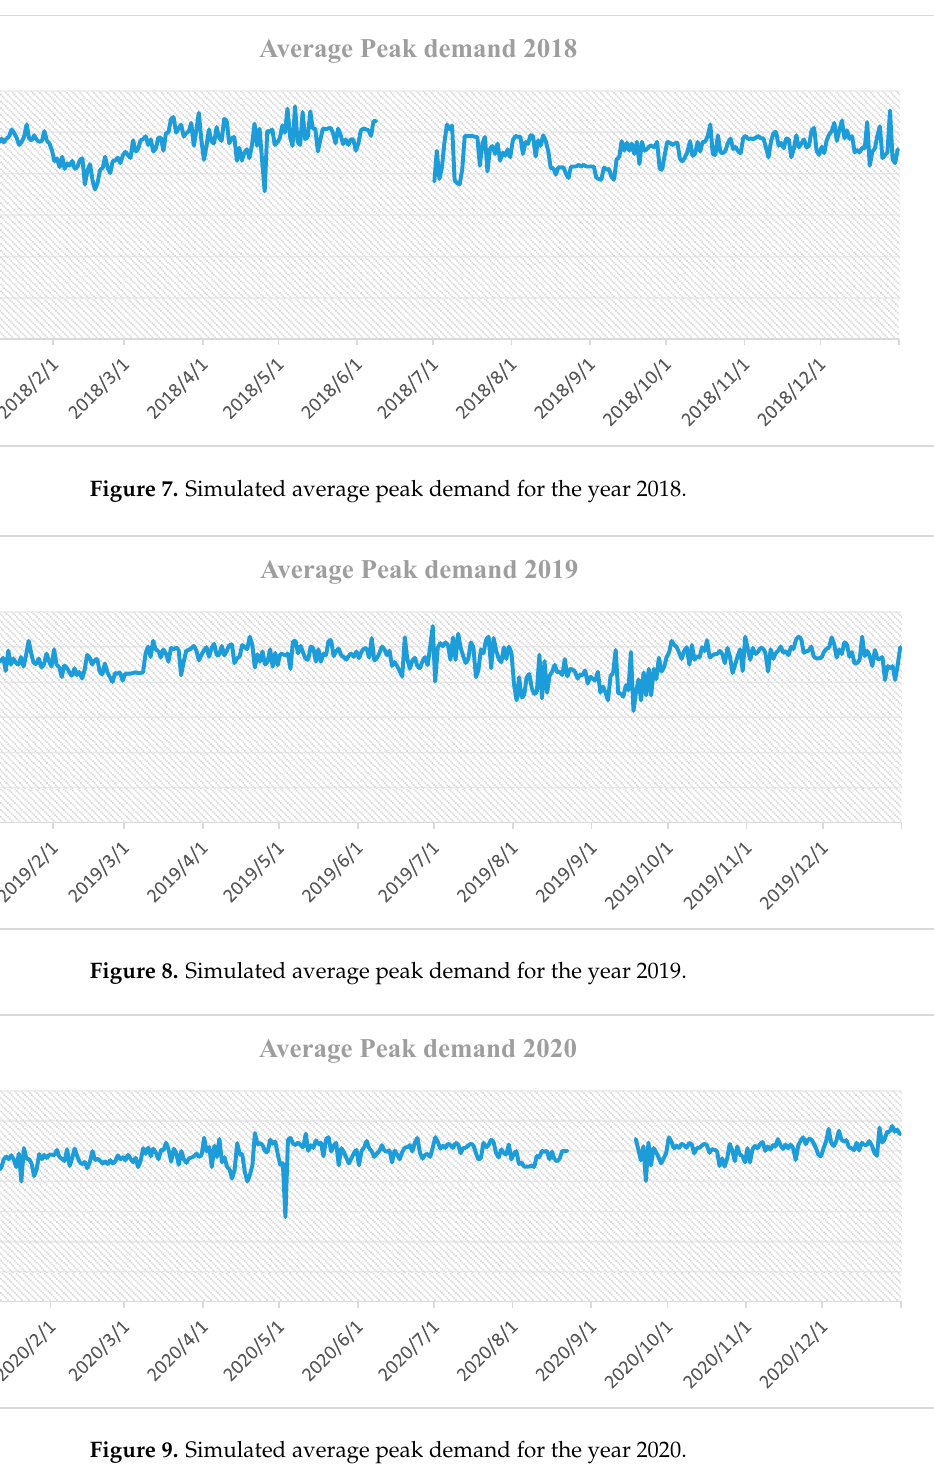
Figure 9. Simulated average peak demand for the year 2020.